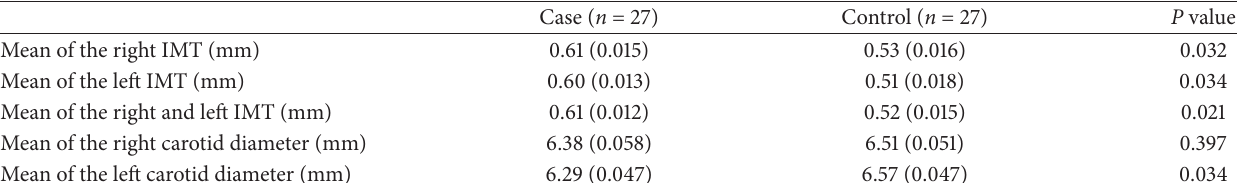
Table 1: Ultrasound examination results.